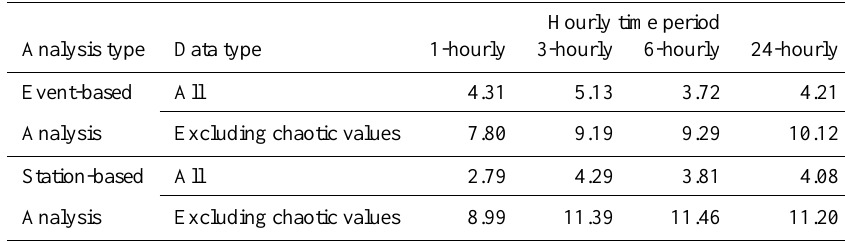
Table 6. Error improvements in [%] with the use of 3DVAR in WRF are given at 1h, 3h, 6h, and 24h intervals for event- and station-based analyses. These improvements are provided for all data and partial data after excluding chaotic values with data